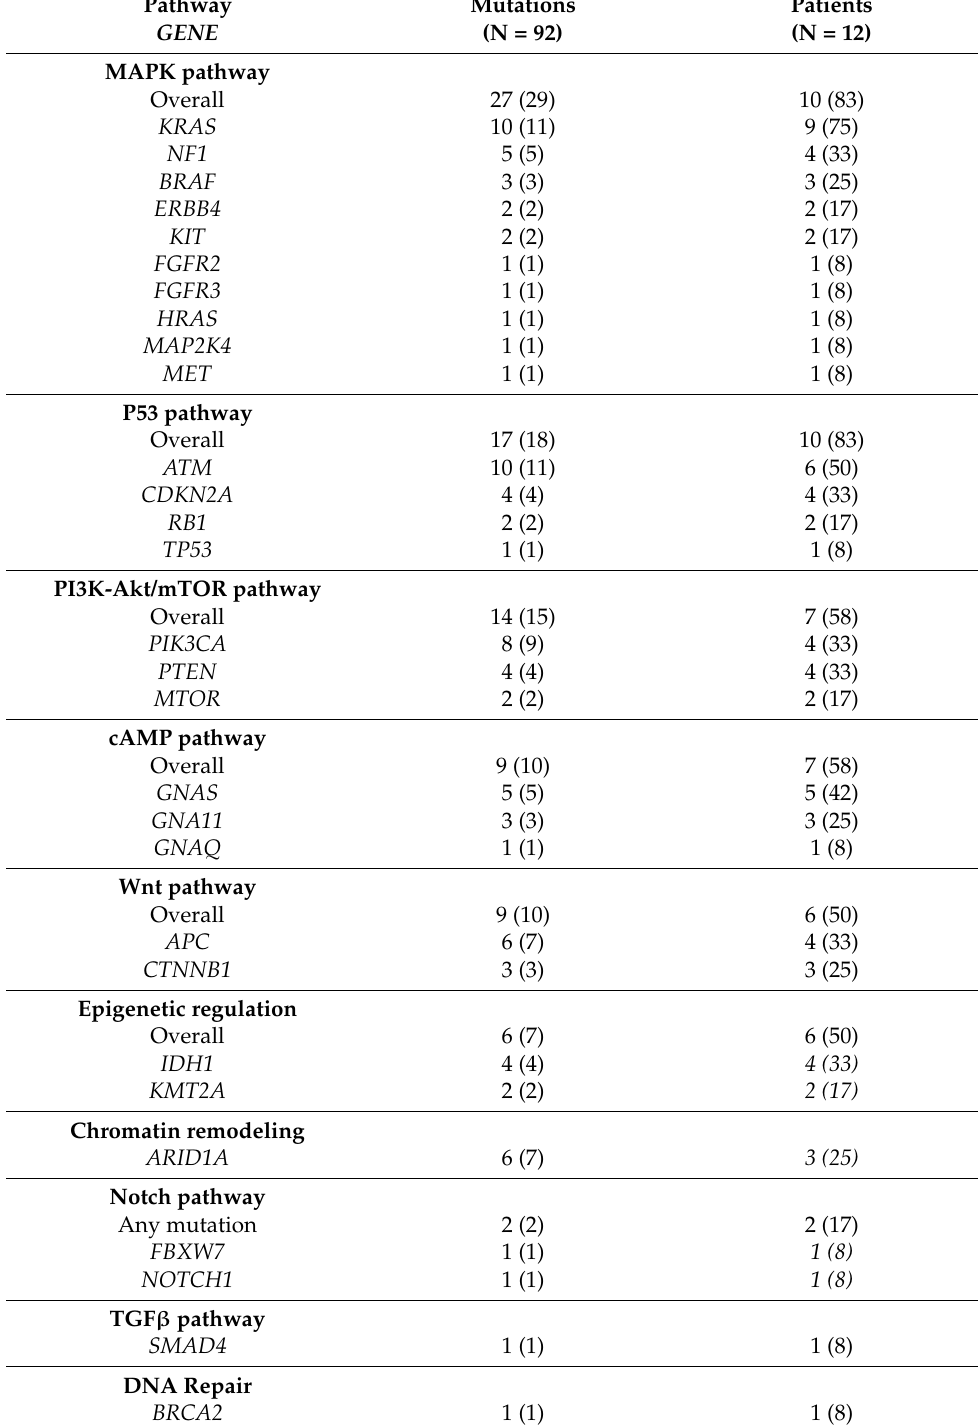
Table 2. Distribution of observed pathogenic or likely pathogenic variants by gene, and number of patients presenting at least one mutation for each